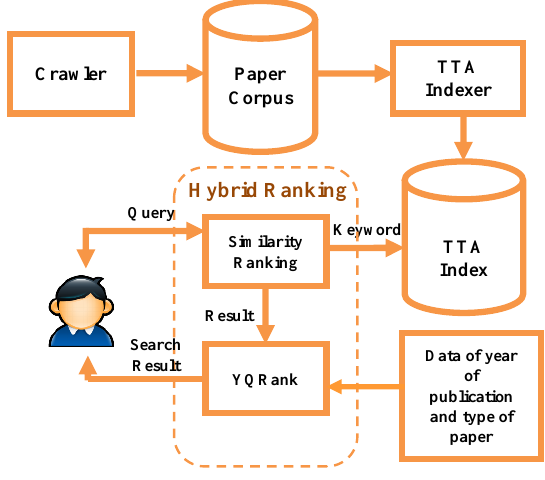
Figure 1. A modified framework for research paper